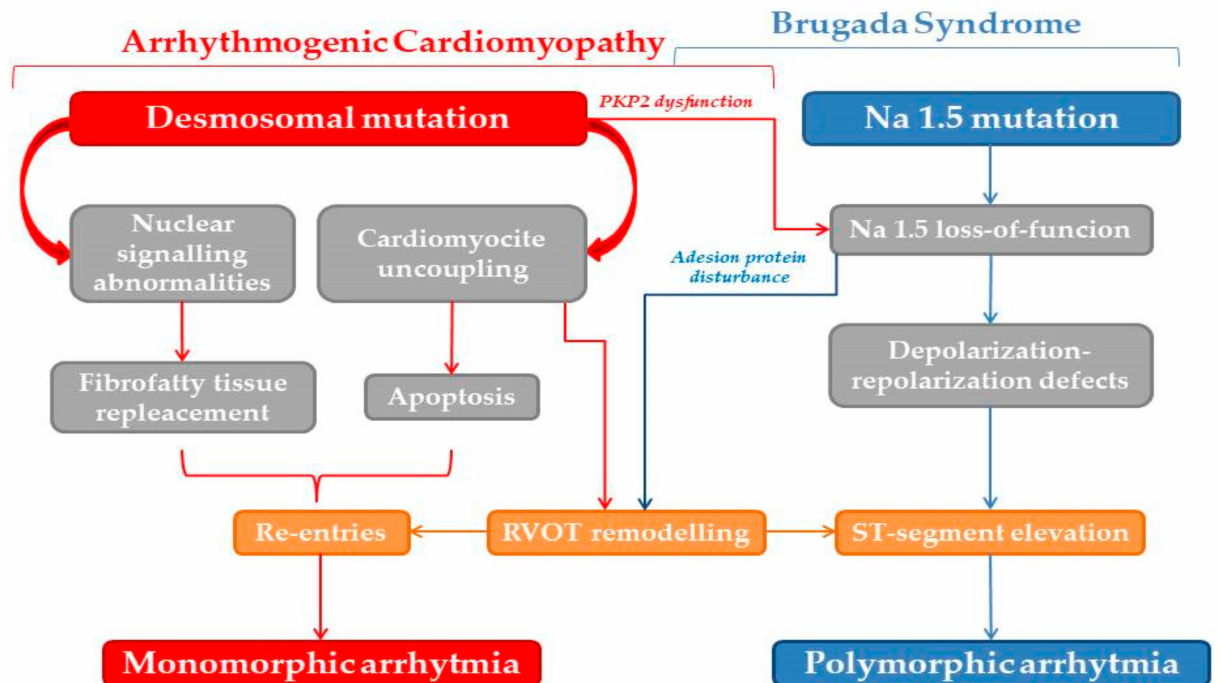
Figure 3. Proposed mechanisms of arrhythmogenic cardiomyopathy (ACM) and Brugada syndrome (BrS). Desmosomal mutations trigger fibrofatty tissue replacement via modulation of the transforming growth factor (TGF) β 1/p38 mitogen- activated protein kinase (MAPK)113, Hippo97, and Wnt/ β catenin signaling pathways. In addition, adhesion defects induce apoptosis in cardiomyocytes; together, these processes contribute to ventricular remodeling, which initially affects the right-ventricular outflow tract (RVOT). Changes in cardiac tissue prompt monomorphic ventricular arrhythmias via a reentry mechanism. By contrast, defects in Nav1.5 or associated proteins (such as PKP2) promote loss of function of the channel, inducing depolarization–repolarization defects. These abnormalities might participate in RVOT remodeling by affecting the function of cell adhesion molecules (such as cadherin 2). According to repolarization and depolarization hypotheses, ST segment elevation on the right precordial leads of the electrocardiogram is a consequence of electrical defects in the RVOT, whereas structural remodeling in the RVOT contributes to those abnormalities in BrS. Remodeling of the RVOT is a mechanism common to the pathogenesis of both ACM and BrS. Modified from Moncayo-Arlandi J, Brugada R. Unmasking the molecular link between arrhythmogenic cardiomyopathy and Brugada syndrome. Nat Rev Cardiol 14, 744–756